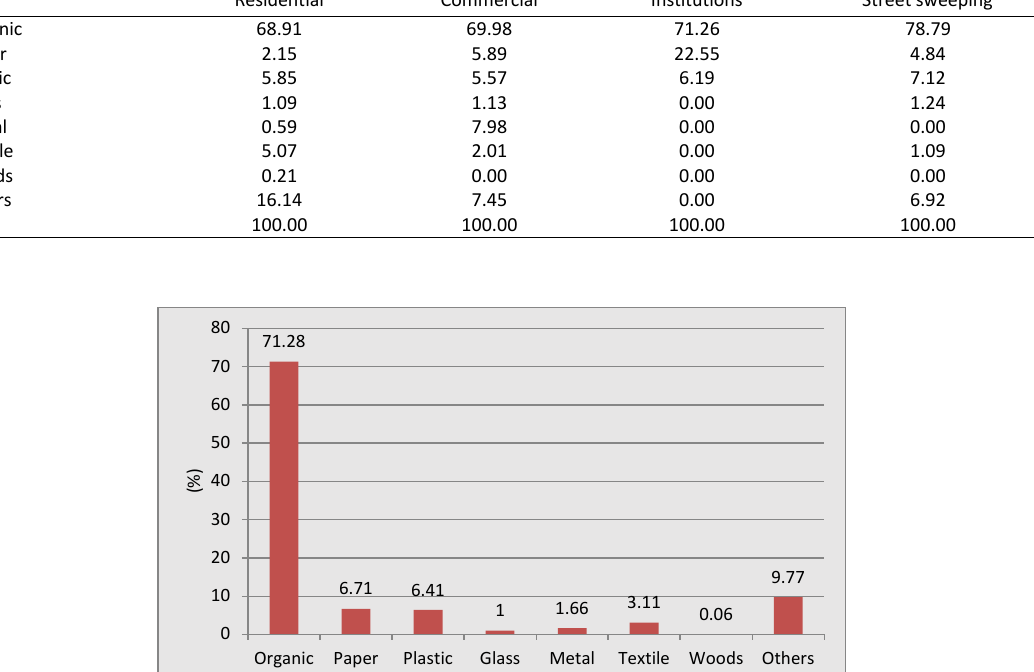
Table 3: Types of solid wastes under different generated sources Types of solid waste